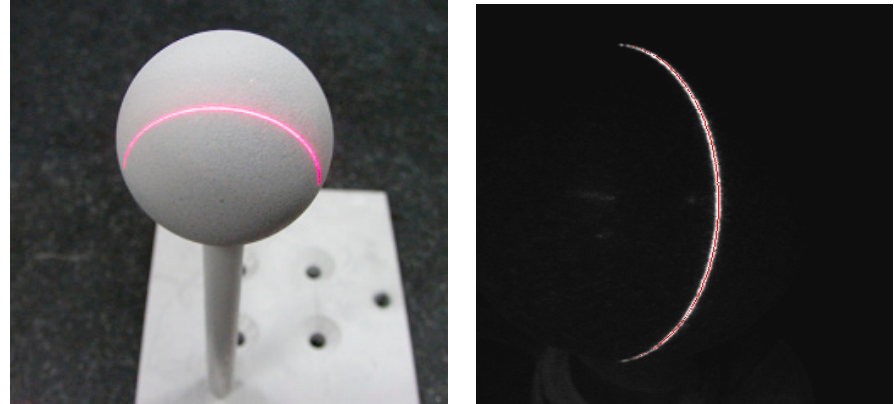
Figure 17. Standard ball measurement: standard ball ( left ) and the extracted projected laser stripe ( right ).